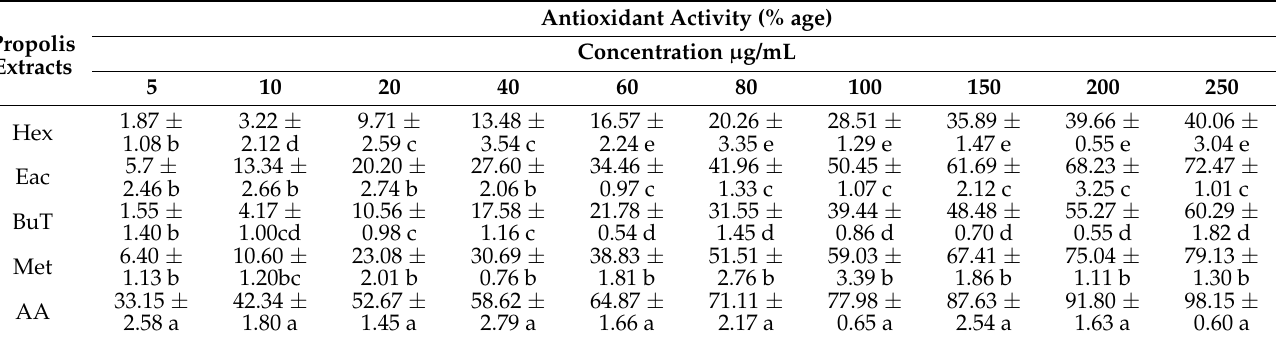
Table 2. Consequences of quantity ( µ g/mL) on antioxidant behavior of different Saudi propolis- based extract.